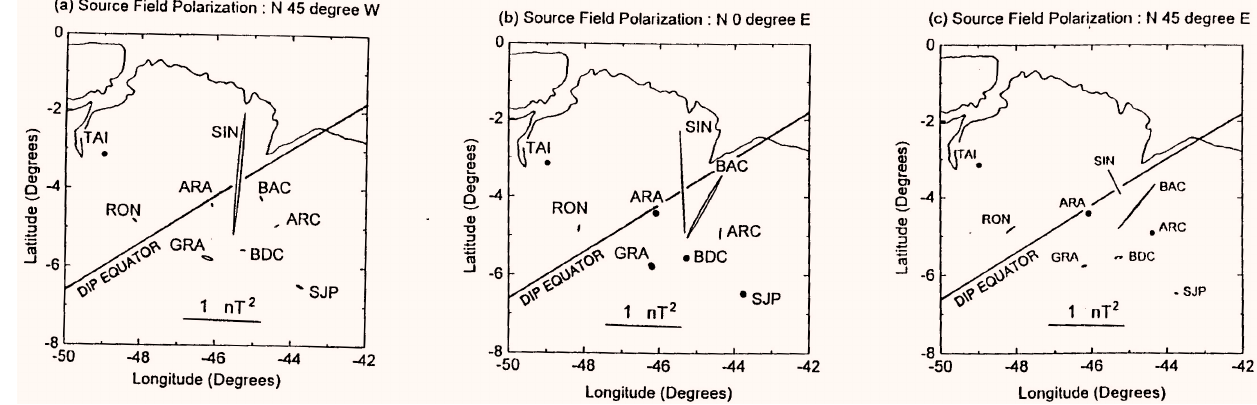
Fig. 7. Ellipses of anomalous horizontal field are shown for three polarizations of the source